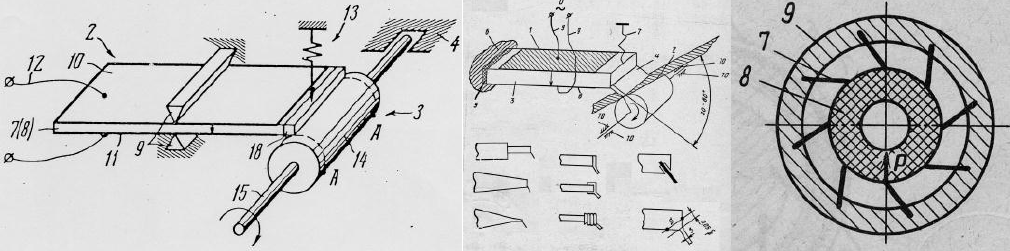
Figure 4. Early structure of various unidirectional piezoelectric motors proposed by Wischnewskiy [5].